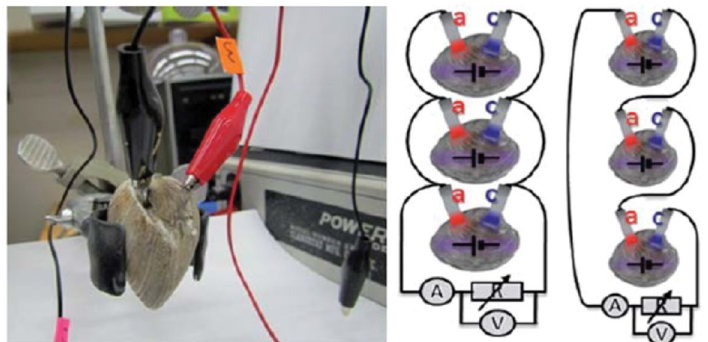
Fig. 18. Photo of a clam with implanted biocatalytic electrodes and circuitries composed of 3 clam-biofuel cells connected in parallel and in serial, respectively